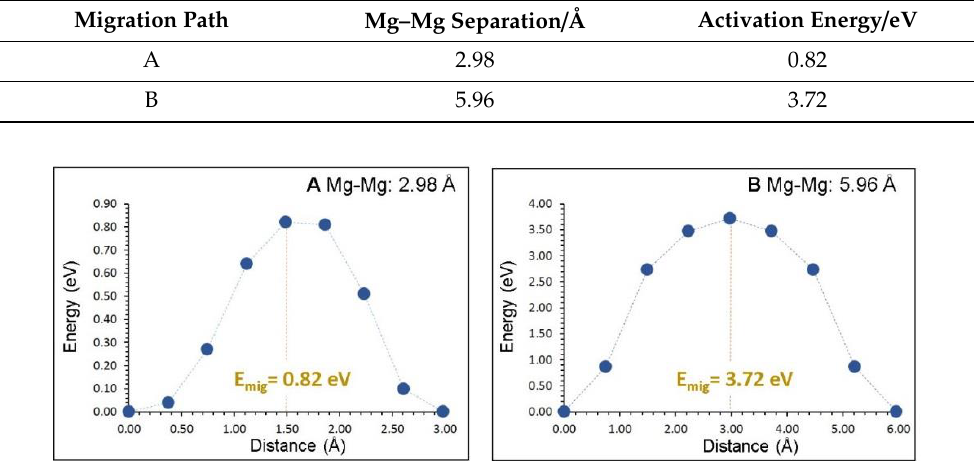
Figure 4. Energy profile diagrams of Mg vacancy hopping between two adjacent Mg sites in Mg 6 MnO 8 (refer to Figure 3). Table 3. Possible long-range Mg-ion diffusion paths and their corresponding overall activation energies.